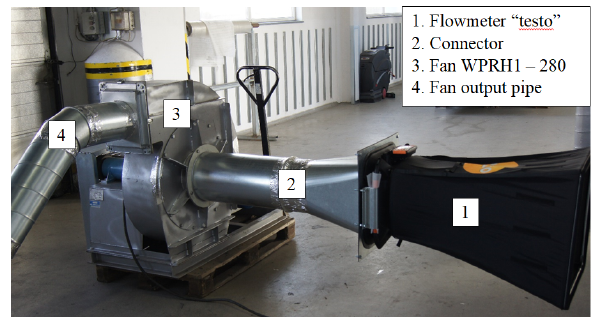
Fig. 6 Initial part of test bench for measurement volume flow rate